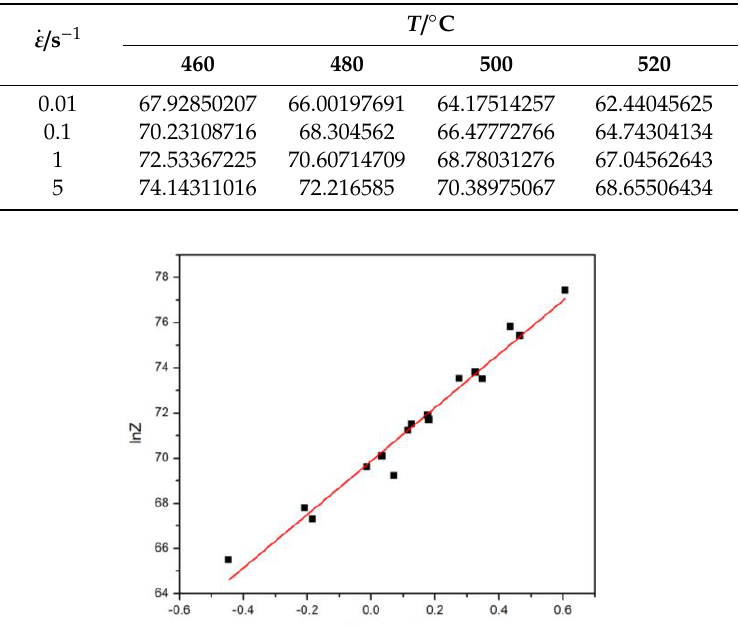
Figure 4. Plots used for calculation of hot-processing parameters. ( a ) ln –lnσ, ( b ) ln –σ, ( c ) ln –